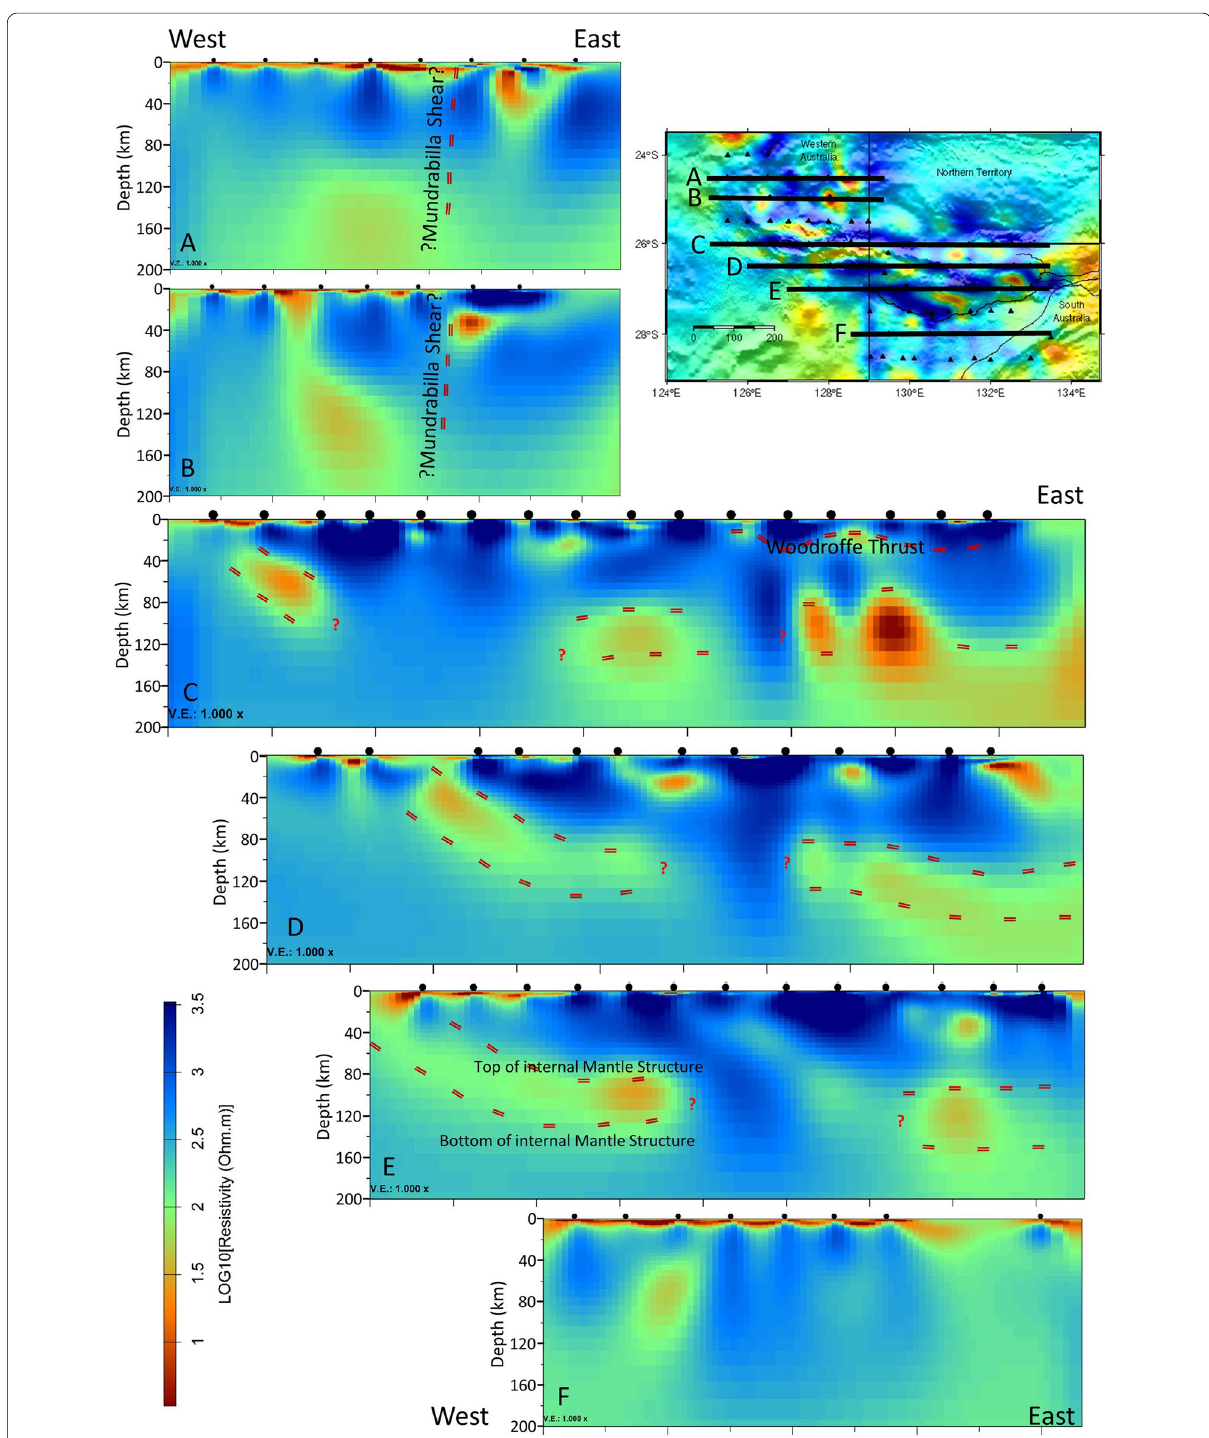
Fig. 8 Composite of six east–west cross-sections through the preferred 3D inverse model of the Musgrave Province. The inferred positions of the Mundrabilla Shear and Woodroofe Shear are shown (Aitken et al. 2016). The red dashed trend lines bound a large layered mantle structure that gently deepens southwards. The Western Australia, Northern Territory and South Australia state boundaries are plotted on the inset map for location